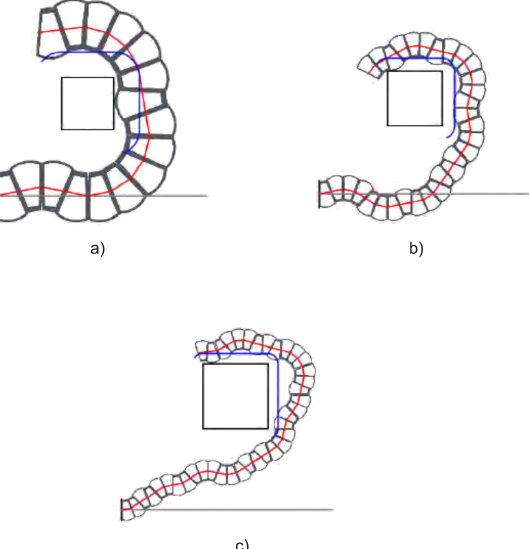
Figure 11. Three examples of 2D grippers for square targets on various scales using the same L-system encoding. Subfigure ( a ) shows a 16-unit actuator, while subfigures ( b , c ) show 31- and 39-unit